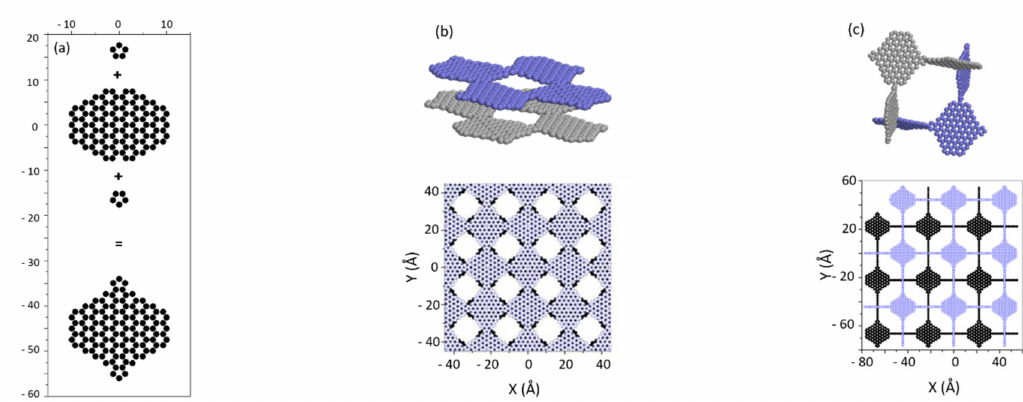
Figure 3. ( a ) Hypothetical polyaromatic molecule used to construct OCFs: half of its specific surface derives from surface of molecule edges; ( b ) 3D slit-like structure (SSA ~3800 m 2 /g) built from supermolecules shown in ( a ); ( c ) 3D orthorhombic structure (SSA ~4400 m 2 /g) built from supermolecules shown in ( a ).